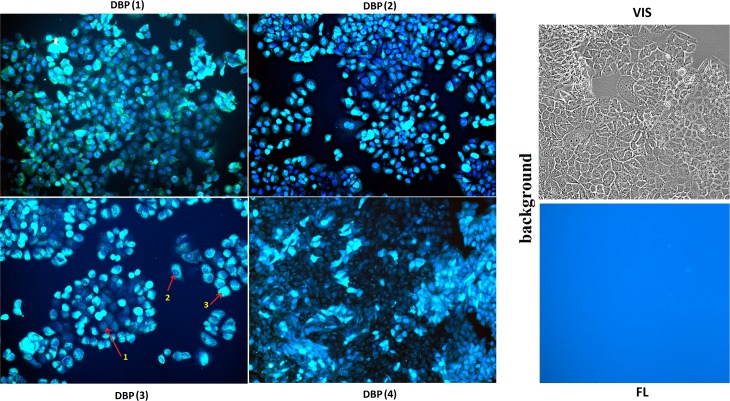
Incorporation of DBP(1–4) in MCF-7 cells.Excitation of fluorescence at 380 nm. Magnification X 20. MCF-7 were incubated with DBP(1–4) (7, 10 or 20 μM) for 24 h and the fluorescence was analyzed in unfixed cells. Staining of the cells was heterogeneous and practically did not depend on the concentrations of DBP(1–4). The 20 μM concentrations of DBP(1–4) were used for an example. The photos of cells were taken with identical exposure. For example the most common nuclei staining types are shown with arrows and numbers: 1 –nucleus is stained only, 2 –nucleus and the cytoplasm are stained. 3- cells show strong blue fluorescence signal while nuclei do not contrast. Background: the photo of control cells in visible light (VIS) and at λex = 380 nm (FL), the exposure is increased two times.